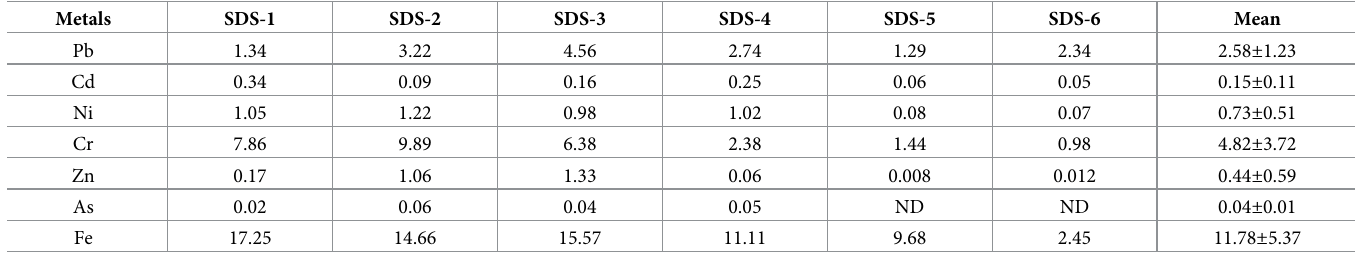
Table 3. Heavy metal levels (mg/kg) in sediment during the wet season.